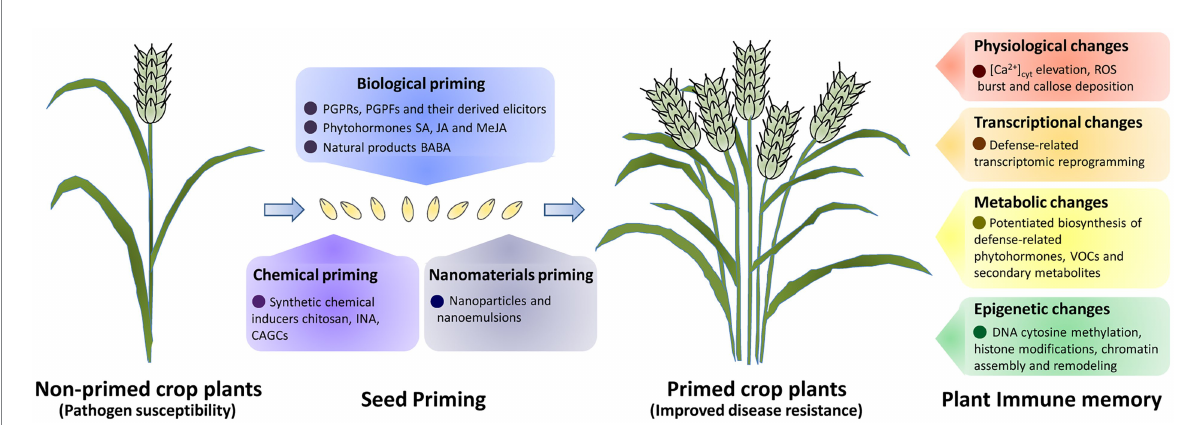
FIGURE 1 A schematic of seed priming and plant immune memory for crop disease resistance improvement. Priming of crop seeds with beneficial microbes and their derived elicitors, phytohormones and natural products, biological primimg could lead to the establishment of immune memory and induced crop disease resistance. Seed primimg with synthetic chemical inducers (chemical primimg), also could improve crop disease resistance. Physiological, transcriptional, metabolic and epigenetic changes are induced in defence priming to establish the immune memory in primed crop